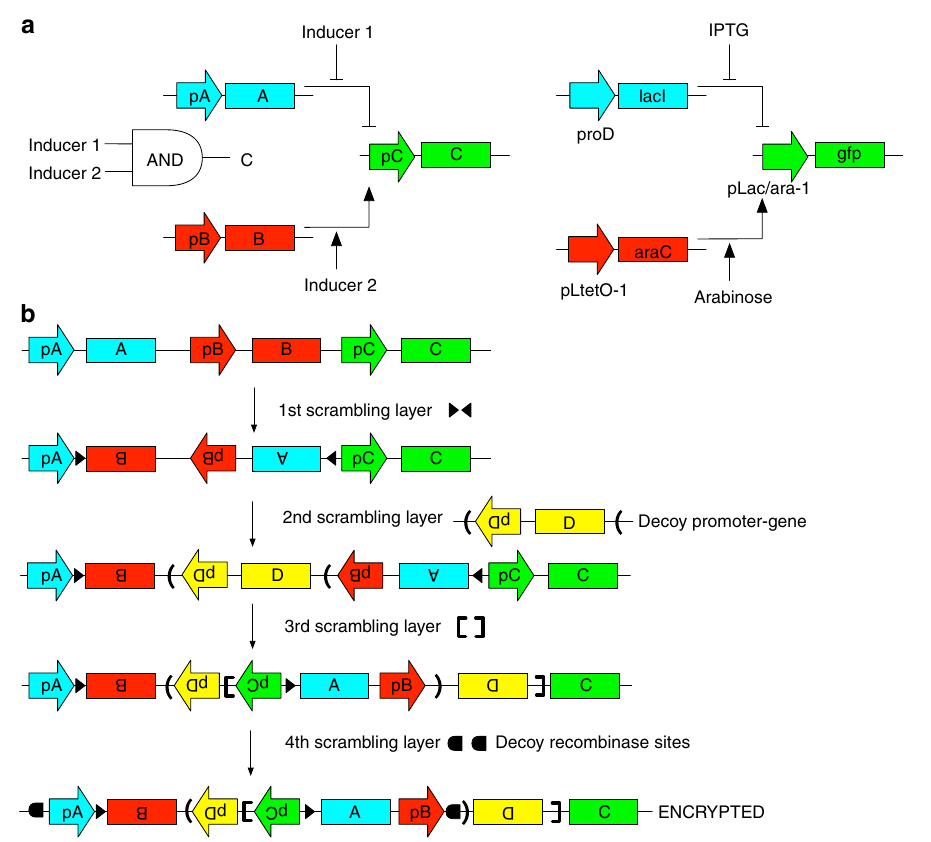
Fig. 1 Encryption of a genetic AND gate using circuit scrambling. a Genetic AND gate. A, B, C ORFs encoding lacI , araC , and gfp , respectively. pA, pB, and pC are the promoters proD, pLtetO-1, and pLac/ara-1, respectively. Inducer 1 (IPTG) inhibits transcriptional repression by LacI, and Inducer 2 (arabinose) activates transcription by AraC. This circuit was tested in cells that do not express the TetR repressor so that pLtetO-1 is constitutively active. b Encryption of the AND gate. At each step, either a new set of recombination sites (decoy or not) or decoy promoter-gene pairs is added. Promoter pD and ORF D are pLtetO-1 and tetR , respectively. Recombinase sites denoted by triangles, brackets, square brackets, and semi-circles are recognized by recombinases TP01, BxbI, Int3, and PhiC31,